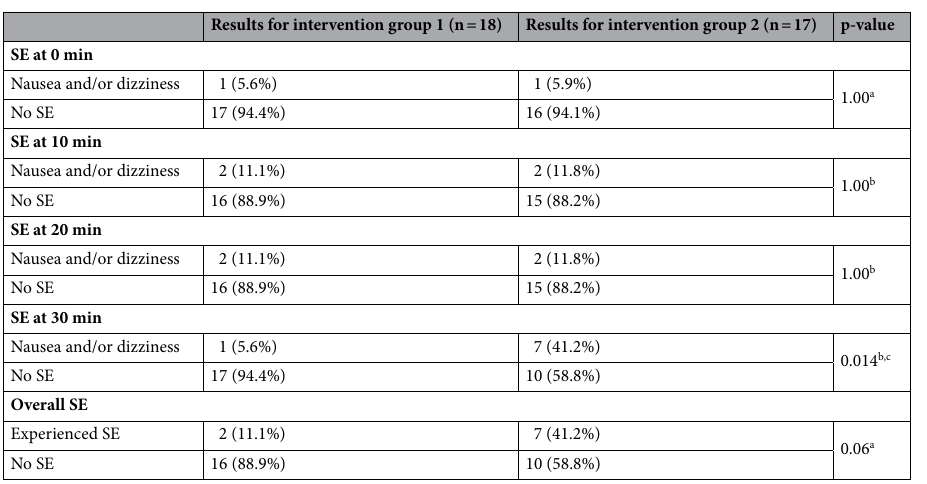
Table 2. Median (IQR) opioid equivalents administered to the intervention groups: prior to commencing protocol; between 0–10; 10–20; and 20–30 min. Mann–Whitney U-test, *Denotes significance.